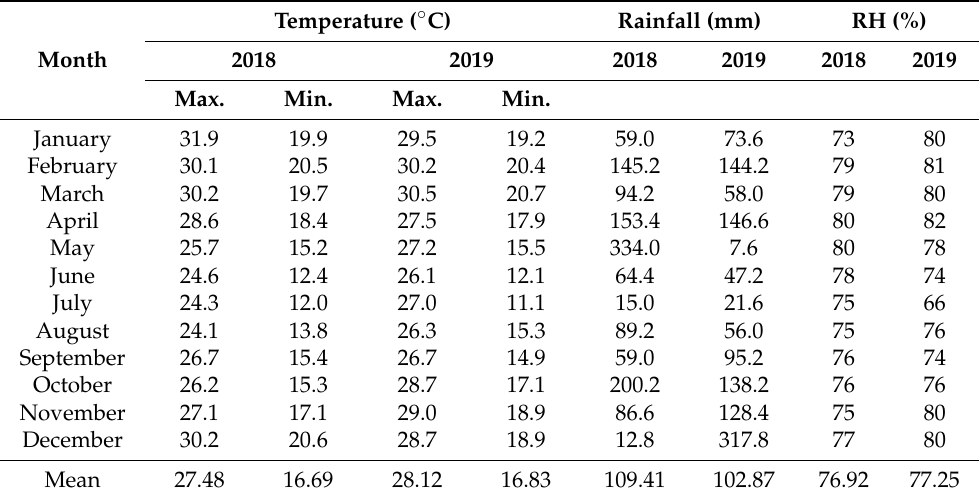
Table 1. Meteorological data of the University of Zululand in 2018 and 2019 (South African Weather Services, Durban,